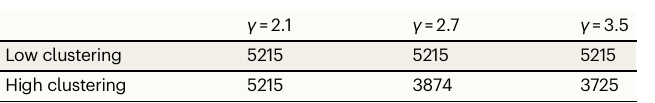
Table 2 | Number of surrogates used to evaluate confusion matrices for different regions of clustering and levels of heterogeneity γ =2.1 γ =2.7 γ =3.5 Low clustering 5215 5215 High